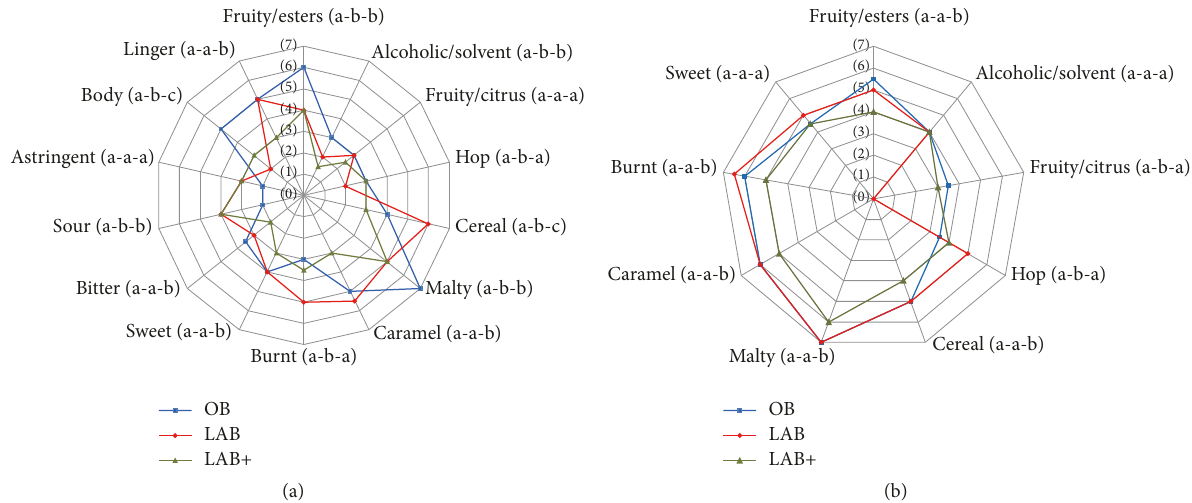
Figure 2: Sensory profile of OB (original beer), LAB (low alcohol beer), and LAB+ (low alcohol beer with supplements): (a) taste and (b) aroma. The letters near the descriptors indicate a statistically significant difference (𝑃 < 0.05) , in the order